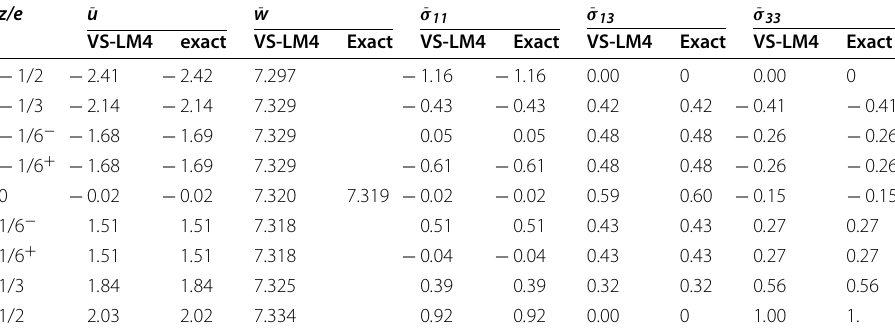
Table 7 Three layers [45 ◦ / − 45 ◦ / 45 ◦ ] – φ = 1 —S=